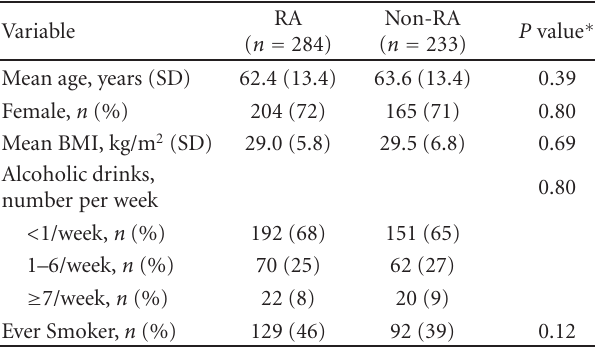
Table 1: Characteristics of RA and non-RA